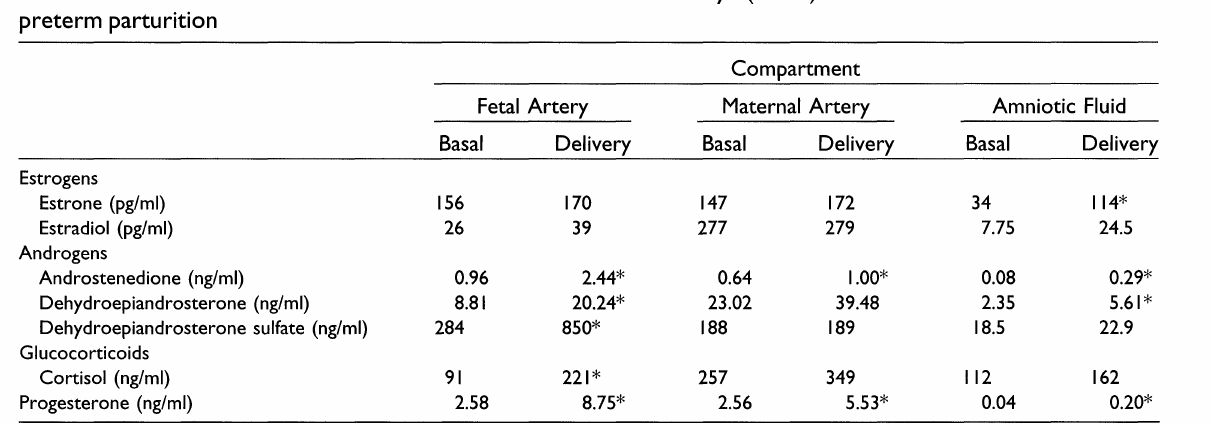
TABLE 4. Median steroid hormone concentrations in rhesus monkeys (n 6) with infection-induced preterm